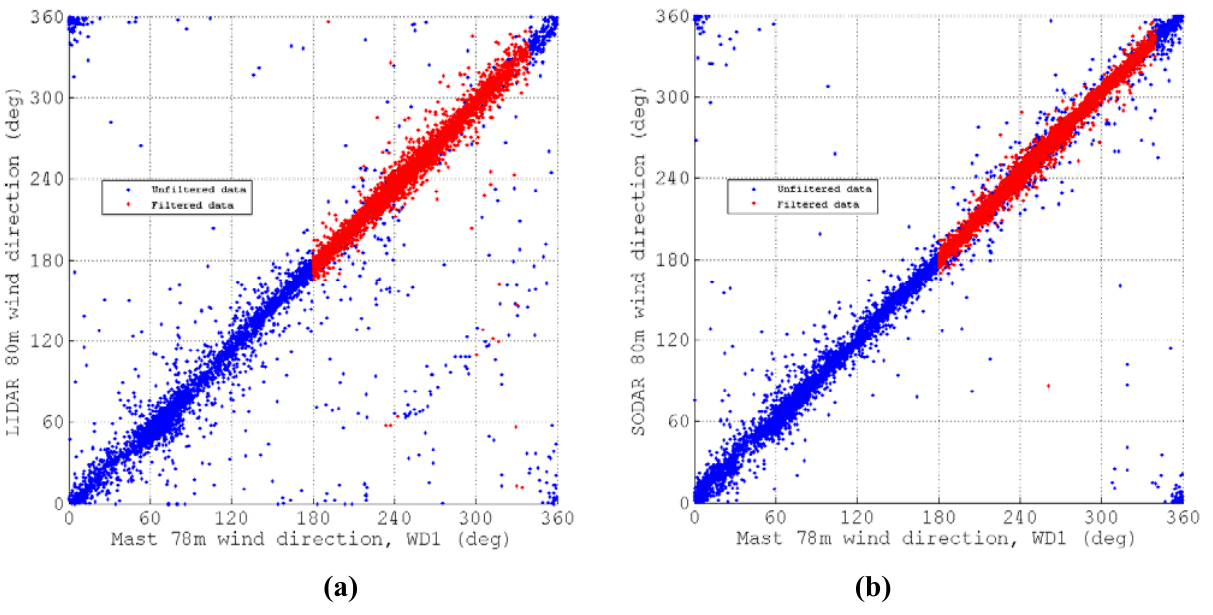
Figure 10. Comparisons of wind direction from (a) LIDAR (80 m) and Mast (78 m); and